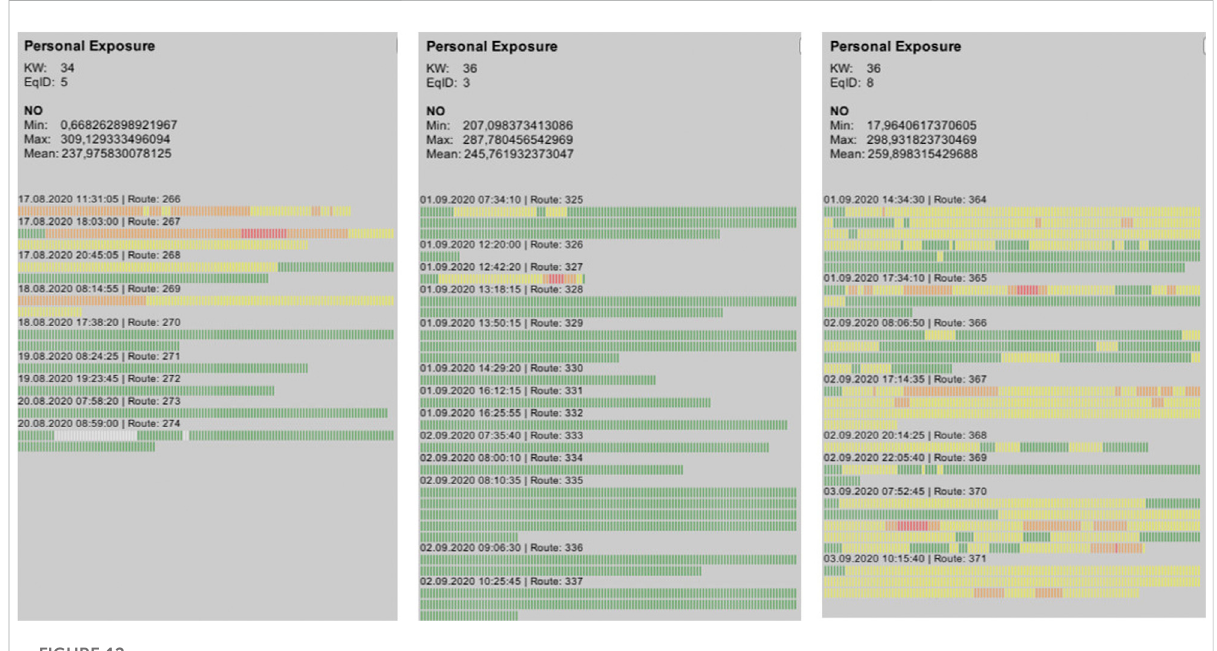
Figure 12). In addition, the questionnaire data of the respective participants were considered in order to analyse whether a particularly high protective behaviour of the participants was indicated, which could explain the values.